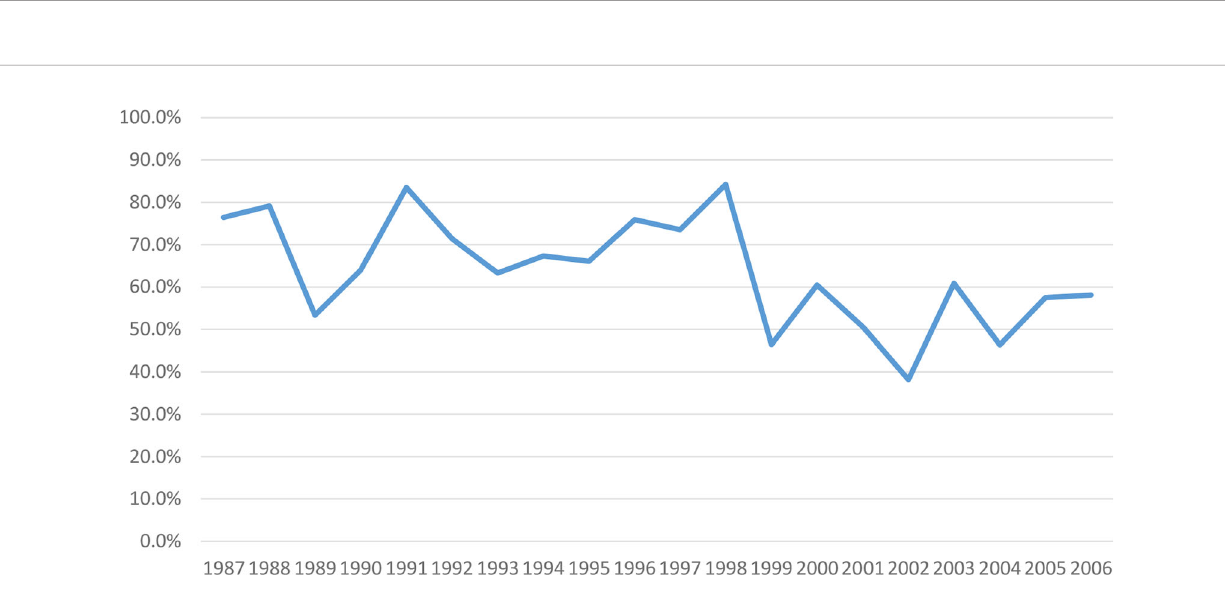
FIGURE 4 | Post-boosters PRNT 80 immune response to WEE vaccine by year within FY87-8 and FY99-12 (1987 – 2006). Immunogenicity of WEE TSI-GSD 210 appeared to decline from 77 –